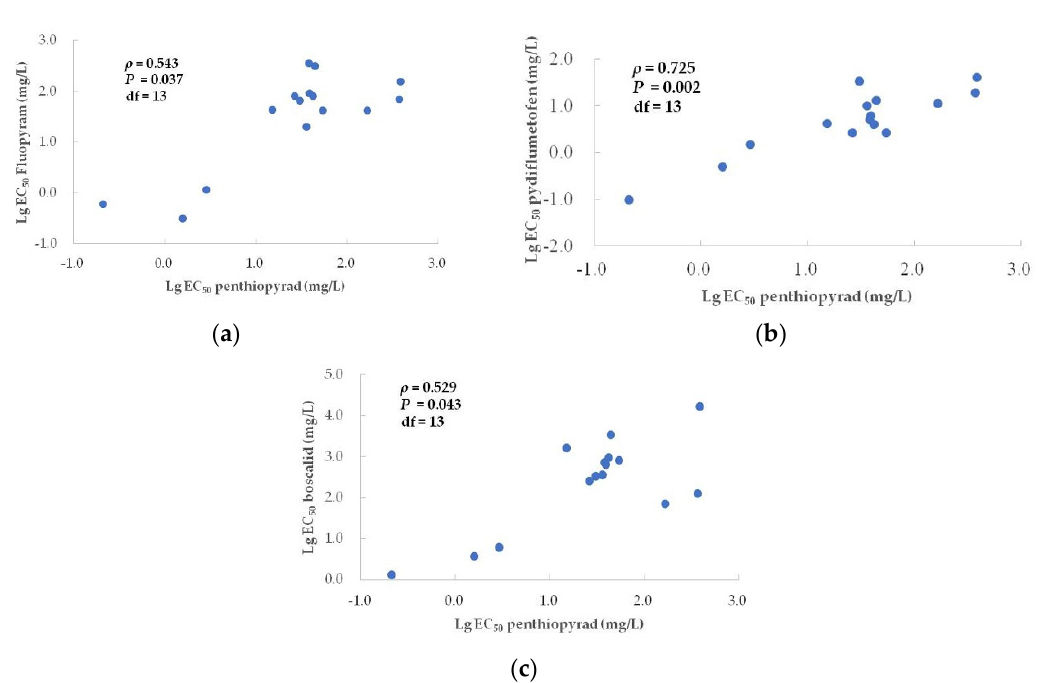
Figure 3. Cross-resistance between penthiopyrad and other fungicides (( a ), fluopyram; ( b ), pyd- iflumetofen; and ( c ), boscalid) was analyzed by Spearman correlation tests in B. cinerea . The EC 50 values of the four SDHI fungicides against 15 B. cinerea isolates with different mutation types in the sdh B subunit were measured by mycelial growth assay on PDA.